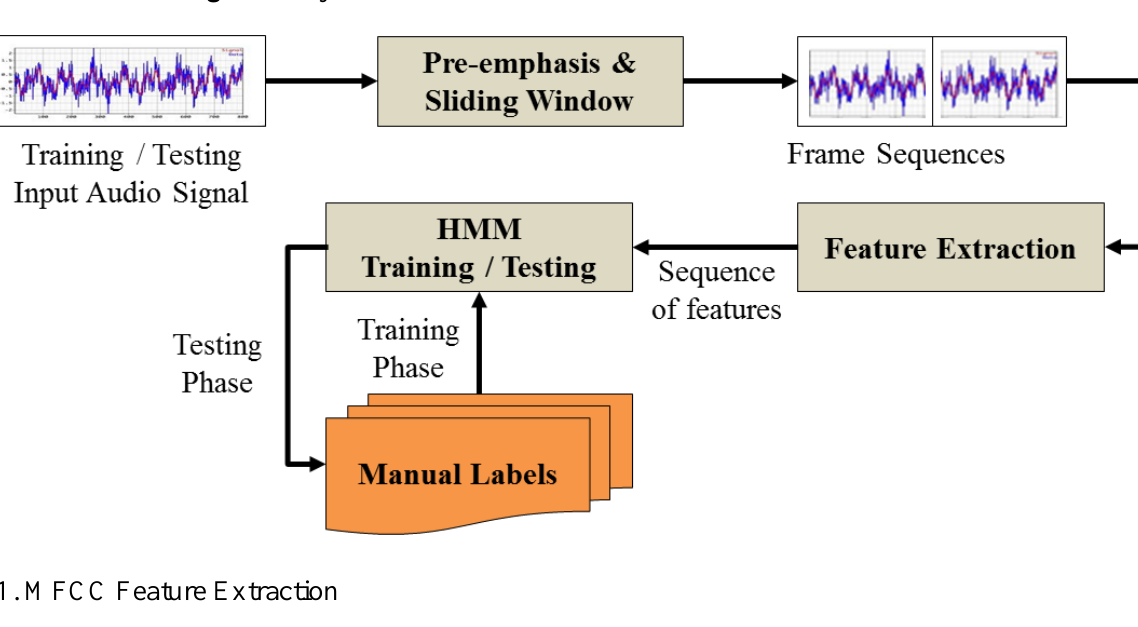
Figure 3. System architecture of the audio classification